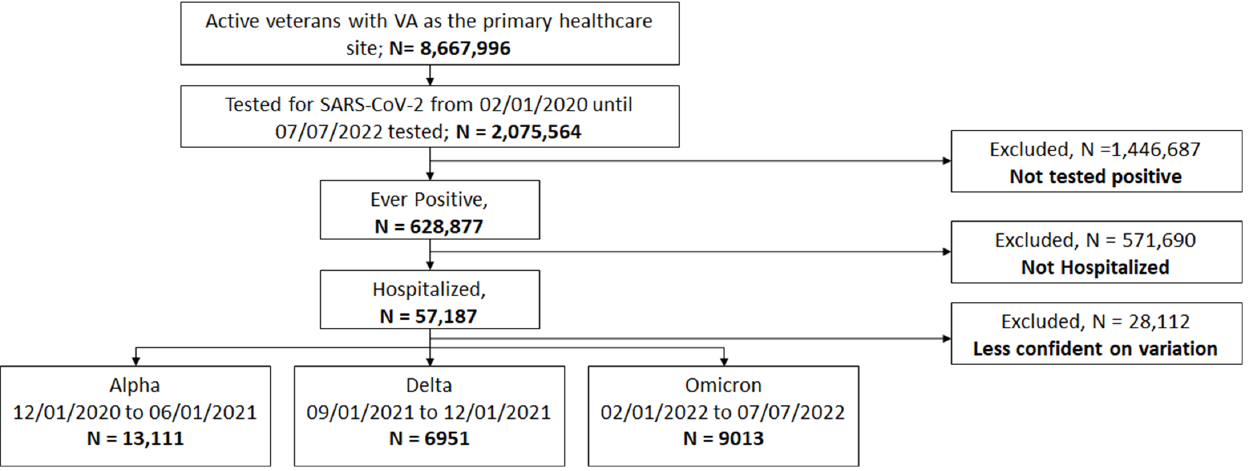
Figure 1. Strobe diagram of patient eligibility determinations for analysis. Table 1. Demographics and clinical characteristics in the Alpha, Delta, and Omicron variation The lowest in-hospital mortality was observed in the Omicron (6.2%) compared to groups among veterans with COVID. Alpha (11.2%) and Delta (13.5%) in Table 3 and Appendix B. The adjusted odds of in- hospital mortality were 1.68-times higher in Alpha (aOR, 1.68, 95%CI: 1.47, 1.91) compared to Omicron, and it was 1.92-time higher in Delta compared to Omicron (aOR, 1.92,